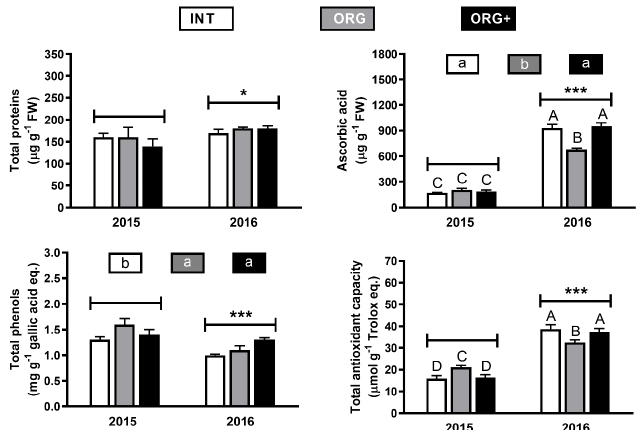
Figure 5. Total proteins, ascorbic acid, total phenols, and total antioxidant activity of processing tomato cultivated according to three different cropping system: integrated (INT), organic farming (ORG),andorganic no-tillage (ORG + ) in a two-year experiment. Each value is the mean ± SD of three replicates. Means keyed with the same capital letter are not significantly different for p = 0.05 following two-way ANOVA using production year (2015–2016) and the three different cropping systems (INT, ORG, and ORG + ) as the variability factors. When the F ratio in the two-way ANOVA interaction was not found significant, data were analyzed by one-way ANOVA using year of cultivation or cultivation systems (considering the average of two years of production) as the variability factor. The presence of asterisks denotes significant differences for p < 0.05 following one-way ANOVA using production year as the variability factor (* p < 0.05 and *** p < 0.001), whilst the presence of different lowercase letters denotes significant differences for p < 0.05 following one-way ANOVA using cropping systems as the variability factor.